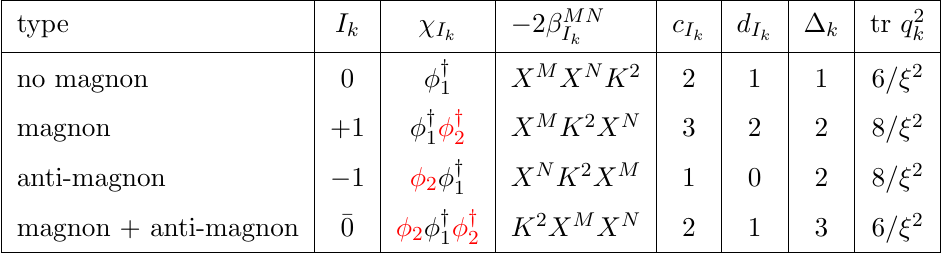
Four types of local composite operators entering into the de(cid:12)nition of the CFT wave